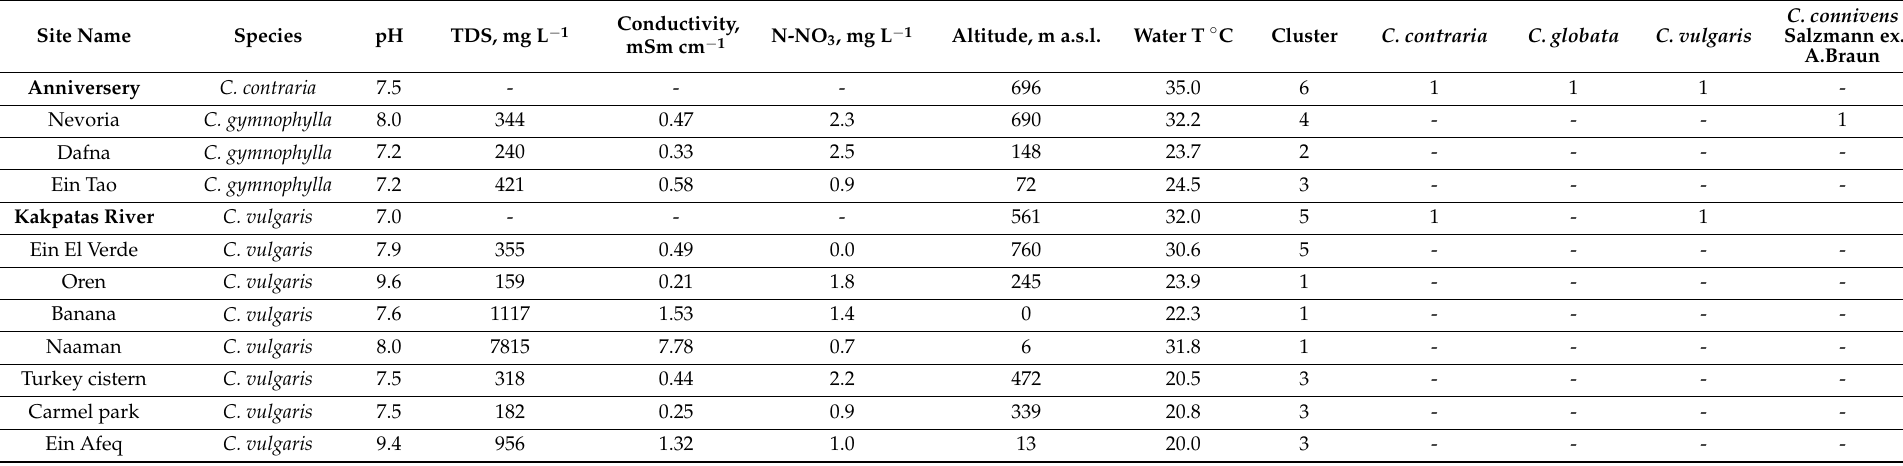
Table 1. Data for species environmental variables and co-occurring species of Chara for the studied sites of south and southeast Kazakhstan (bold) and Israel (S. Barinova own